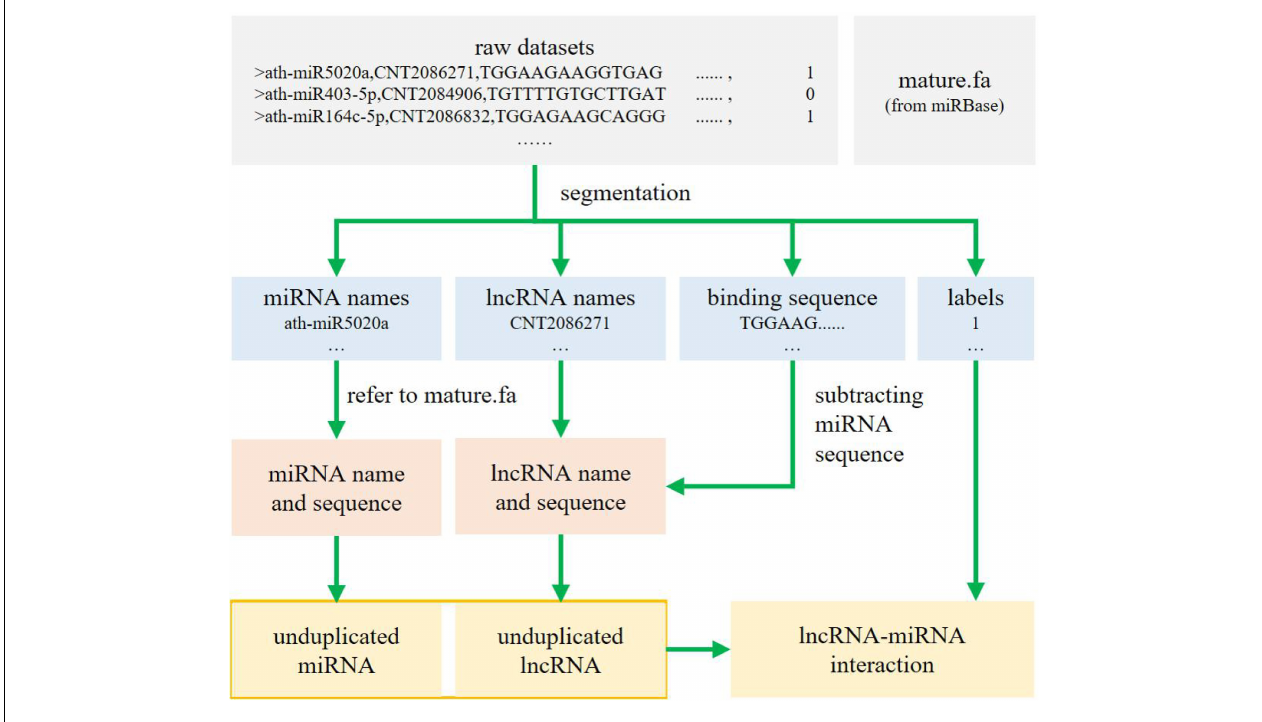
FIGURE 1 | Dataset